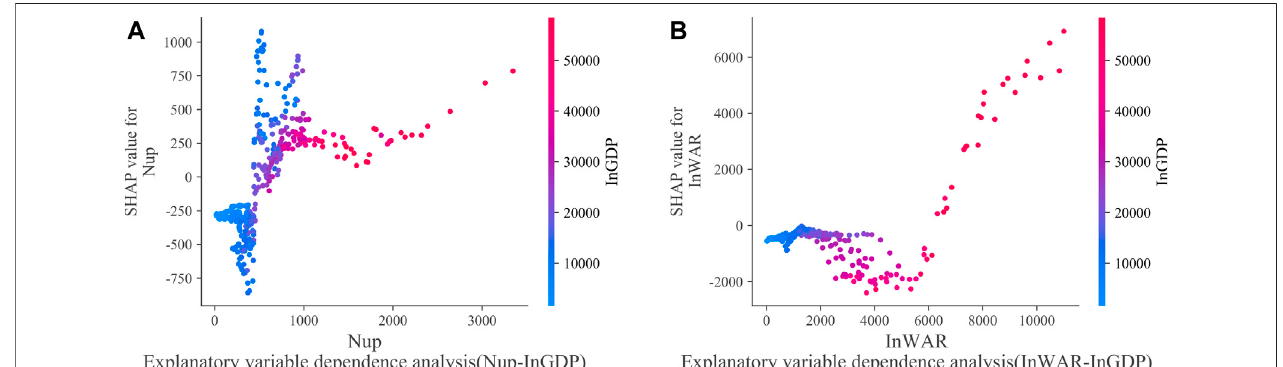
FIGURE 9 | Feature dependence analysis. (A) is Nup and InGDP . (B) is InWAR and InGDP